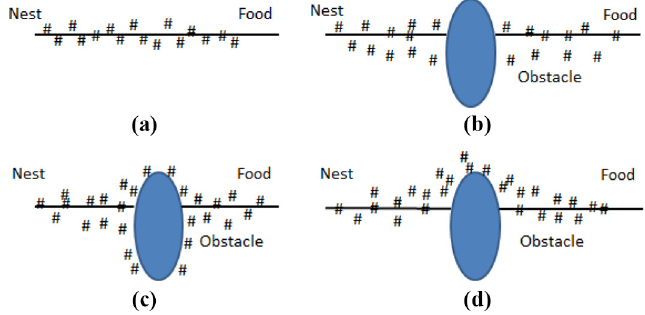
Figure 5. Foraging diagram